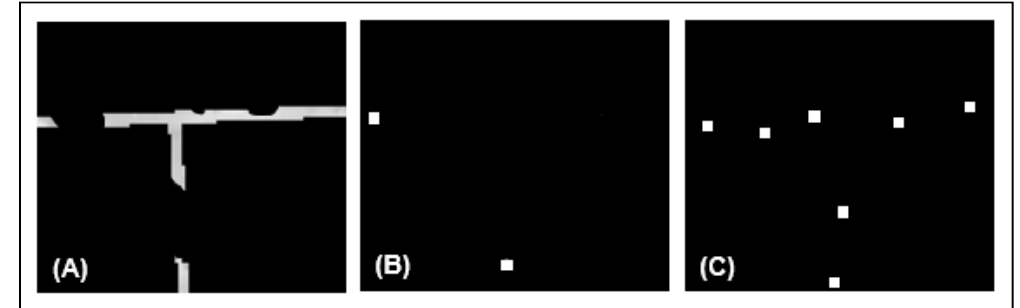
wide Road mask. ( B ) A sample of the 0.5% test pixels derived from the road shown in (A). ( C ) An example of the selected training pixels (one sample per 10 m * 10 m grid) extracted from the road in (A). (B) and (C) confirm that Road training and test samples are independent of each other.